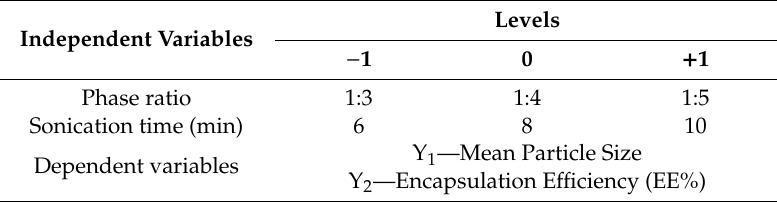
Table 1. Factors and levels used in the design of experiments. Independent Variables